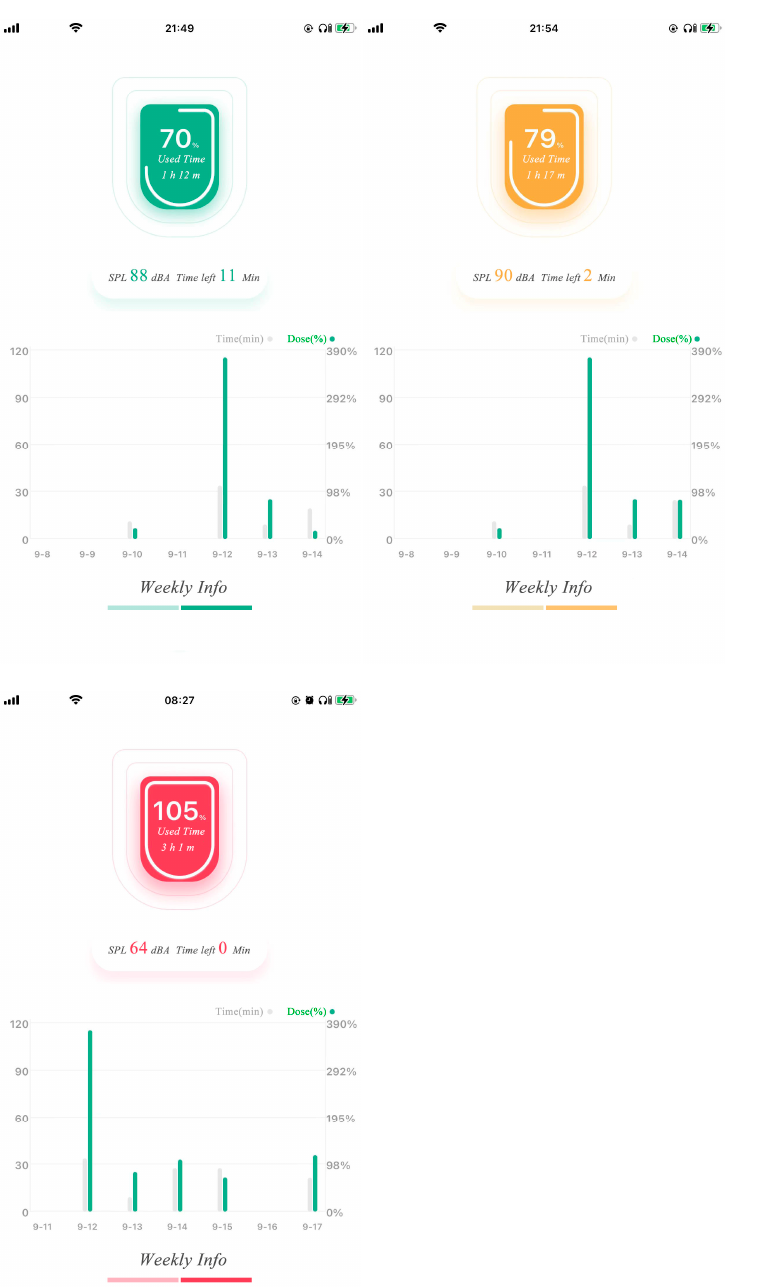
Figure 8. Weekly dose usage